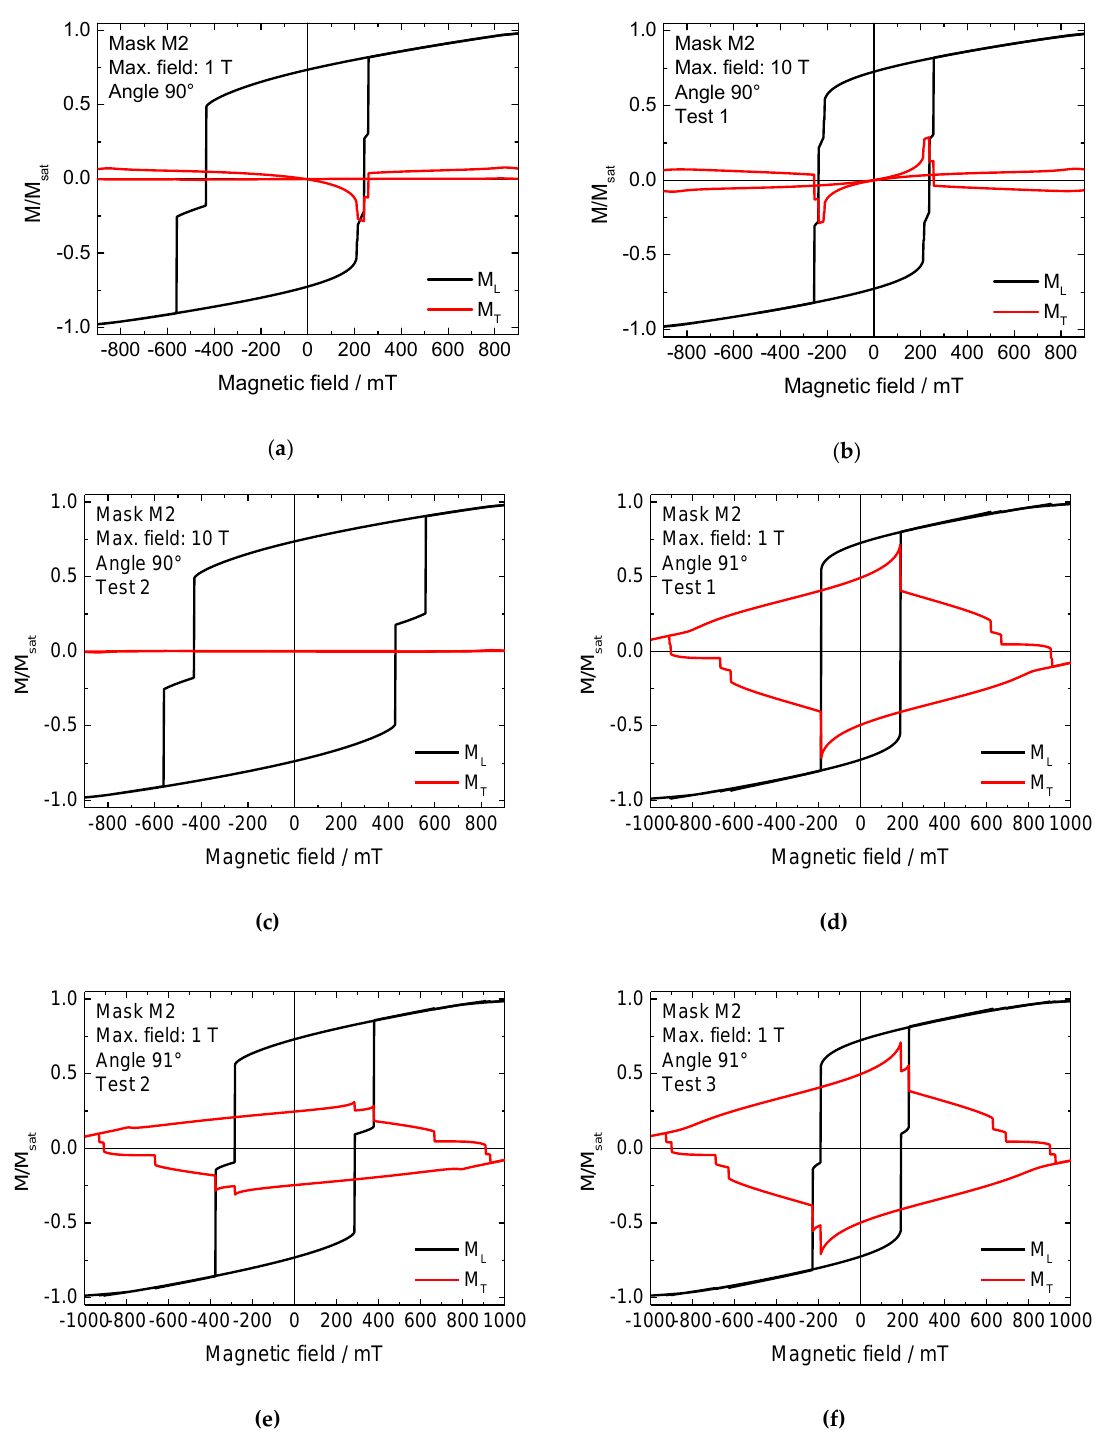
Figure 4. ( a – f ) Longitudinal and transverse hysteresis loops ML and MT, simulated for mask M2 under a field angle of ~90 ◦